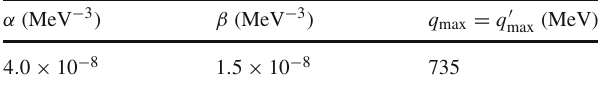
Table 1 Parameters from a fit to the experimental